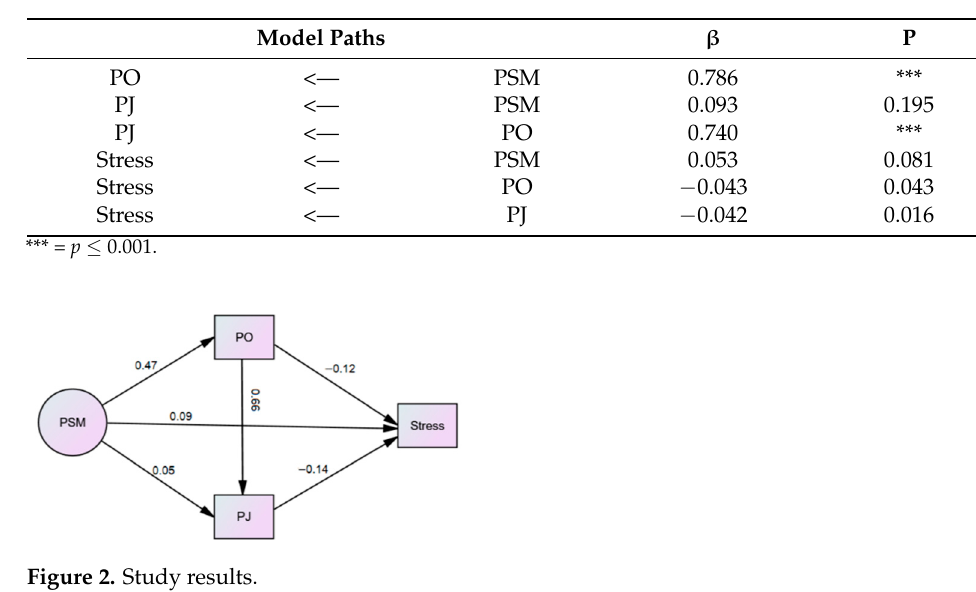
Table 5. Study variables estimates by model paths.